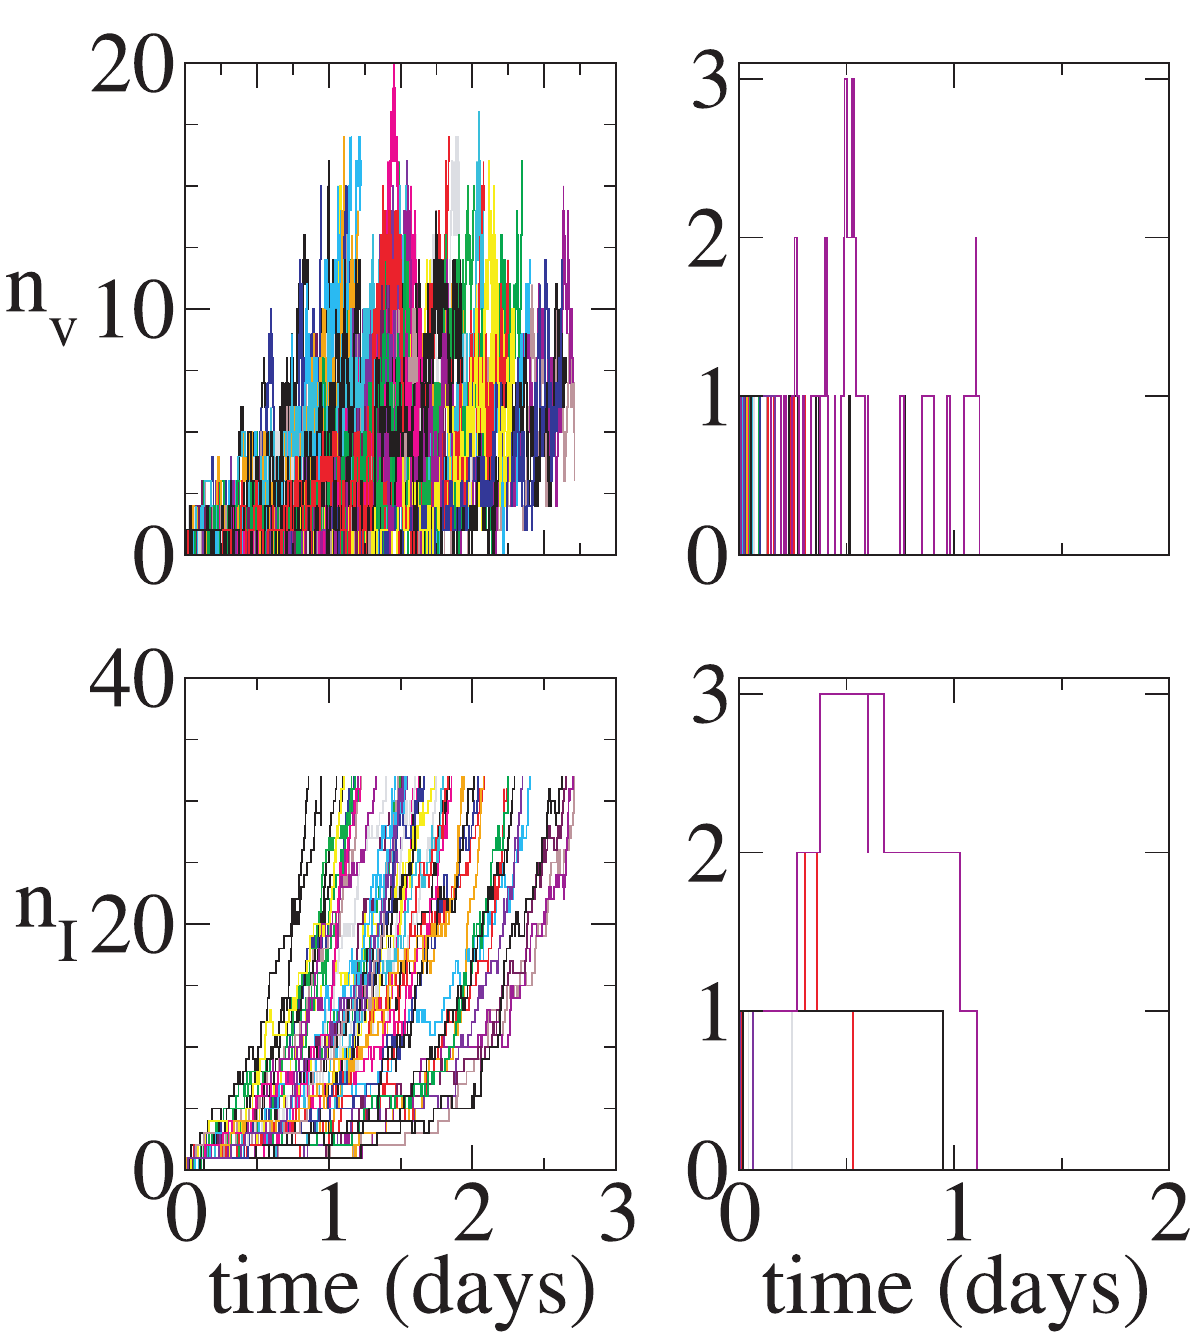
Figure 5. Continuous model. Representative time series. Initial condition: n V ~ 1 , n I ~ 0 . Left column: 100 realizations that lead to infection. Right Column: 100 realizations that lead to